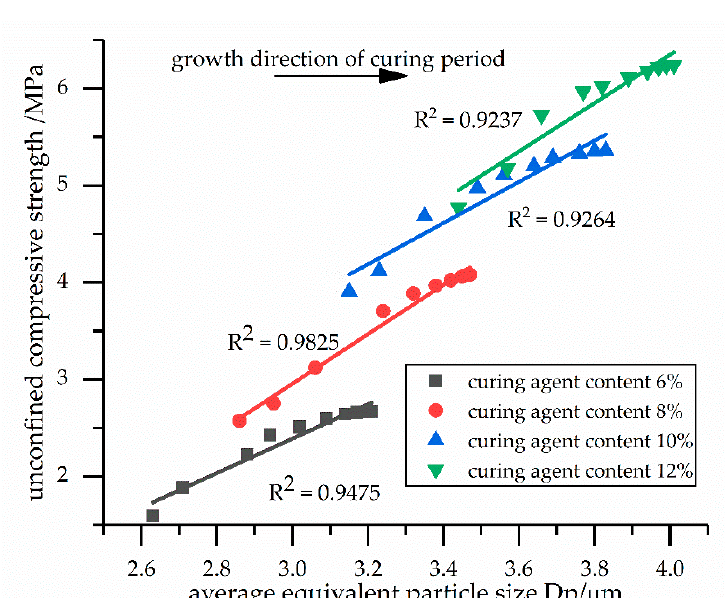
Figure 6. Relationship between the unconfined compressive strength and the average equivalent particle size.